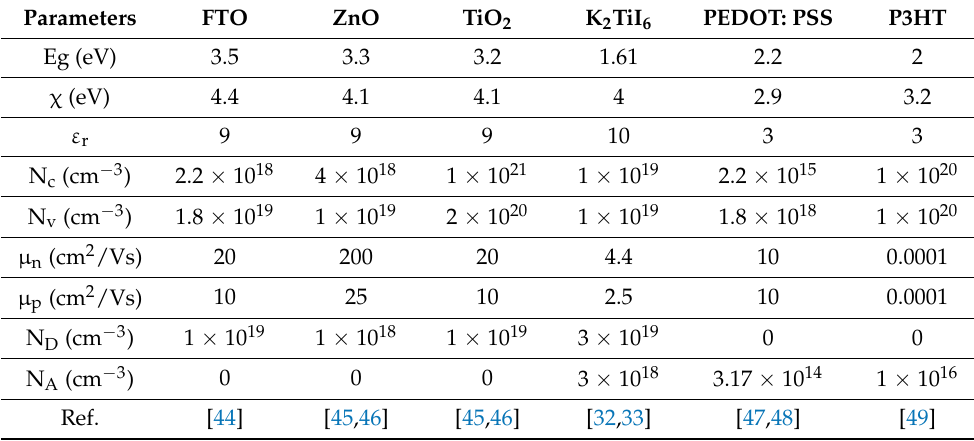
Table 2. Parameters used in simulation of K 2 TiI 6 based PSC.